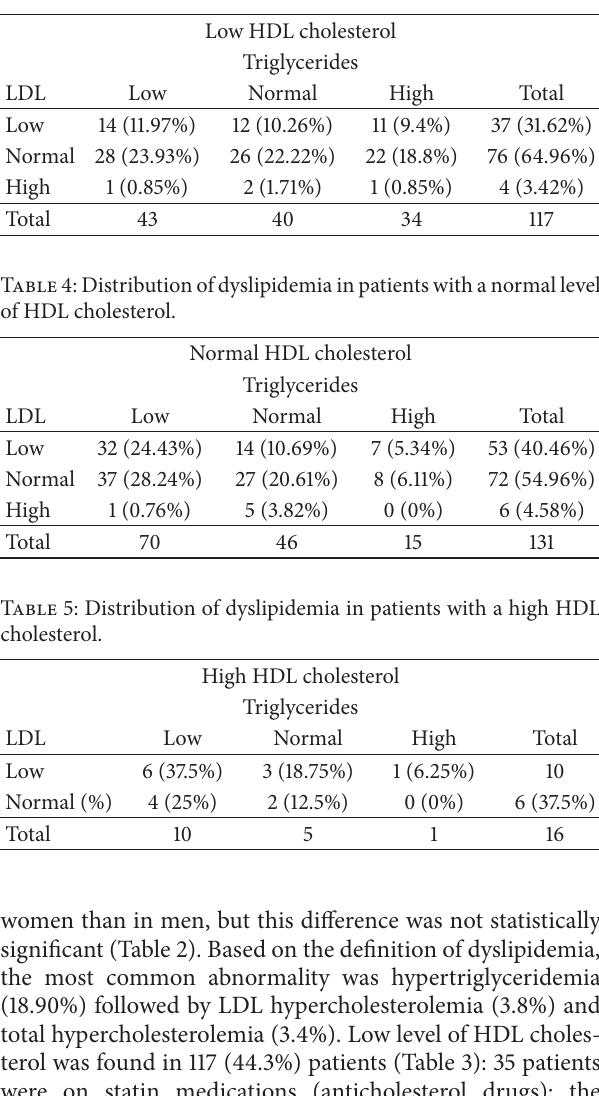
Table 3: Distribution of dyslipidemia in patients with a low HDL cholesterol.